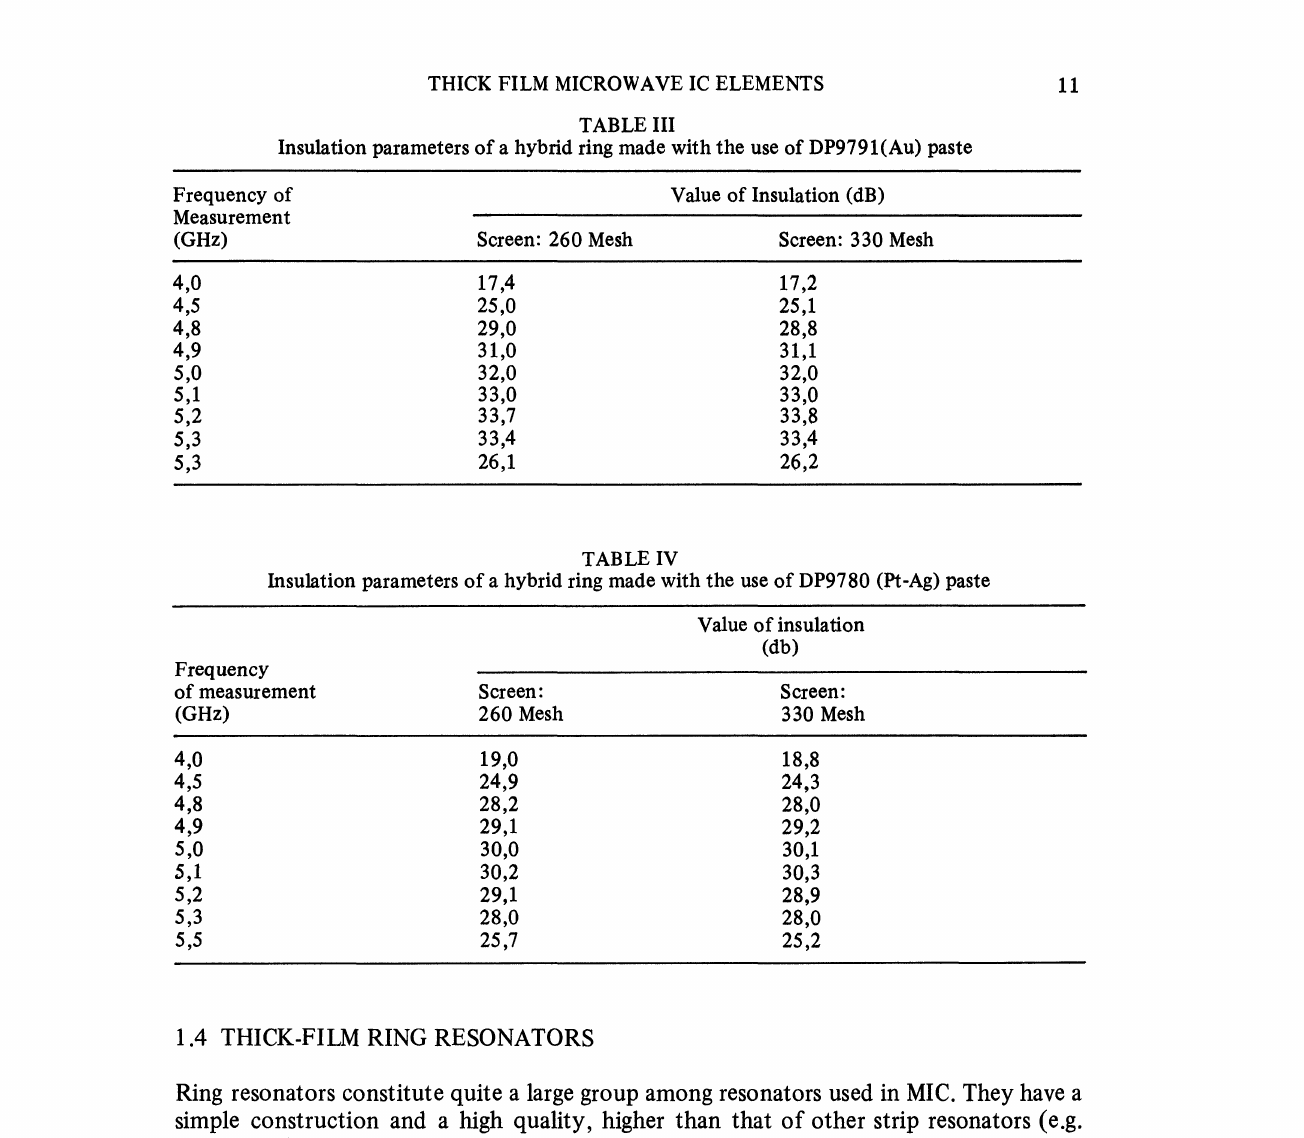
TABLE III Insulation parameters of a hybrid ring made with the use of DP9791(Au) paste